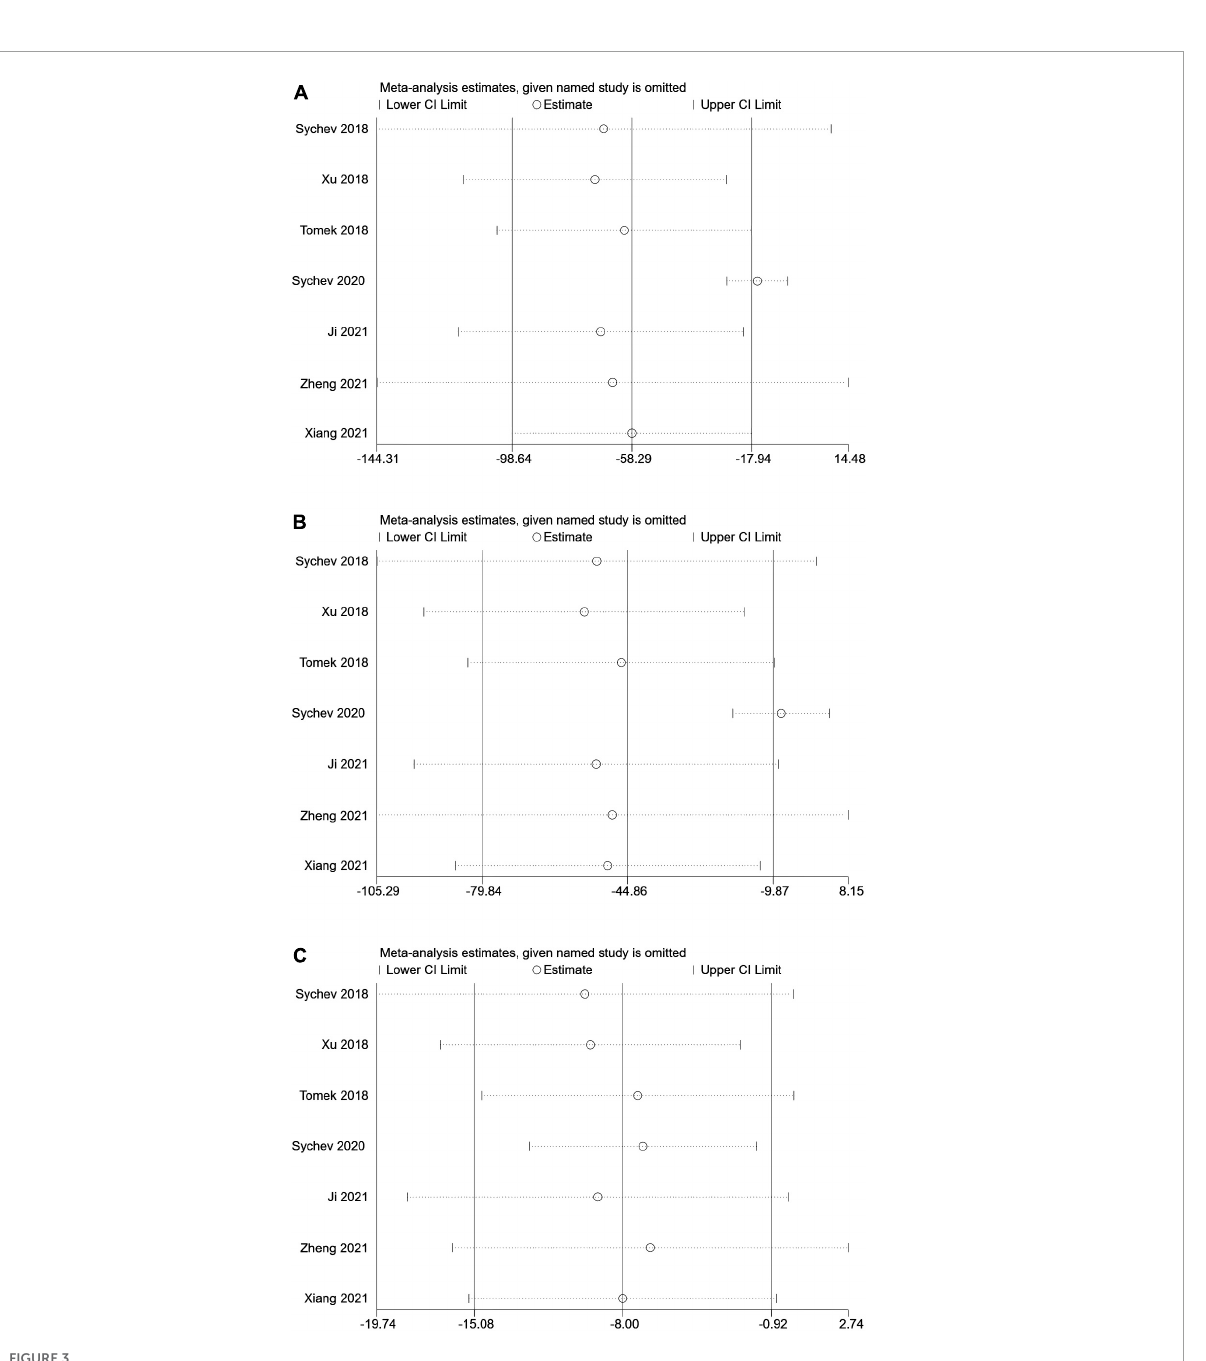
allele patients, the expression of CES1 was significantly lower in GG. sQTLs showed genome-wide significance in seventeen tissues ( p < 5 × 10 − 8 ) in Figure 7C and Supplementary Figure 2 . Particularly, finding the cis -eQTL and sQTLs genotypes implicated the rs2244613 variant as a transcriptional regulatory